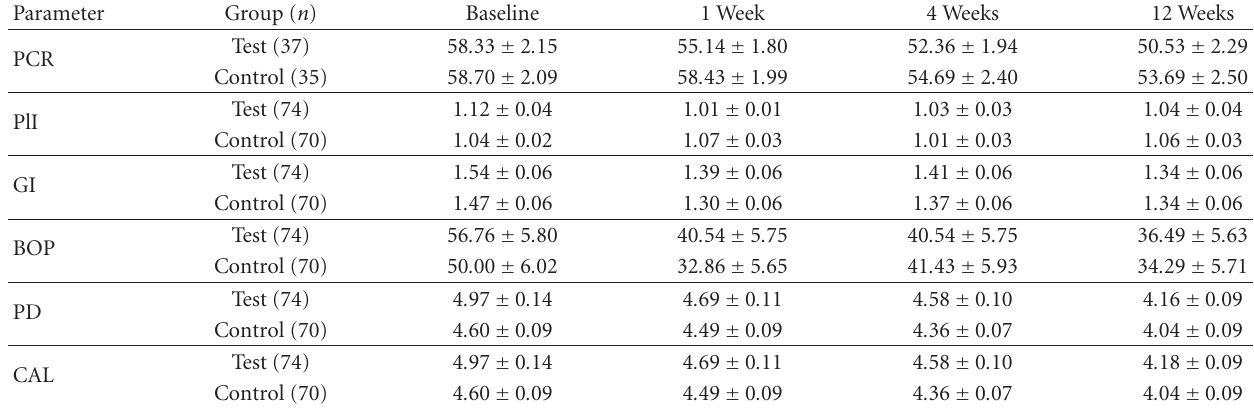
Values represent the mean ± standard error. PCR: plaque control record (%). PlI: plaque index. GI: gingival index. BOP: bleeding on probing (%). PD: probing depth (mm). CAL: clinical attachment level (mm). PlI, GI, BOP, PD, and CAL were assessed in two teeth with chronic periodontitis per